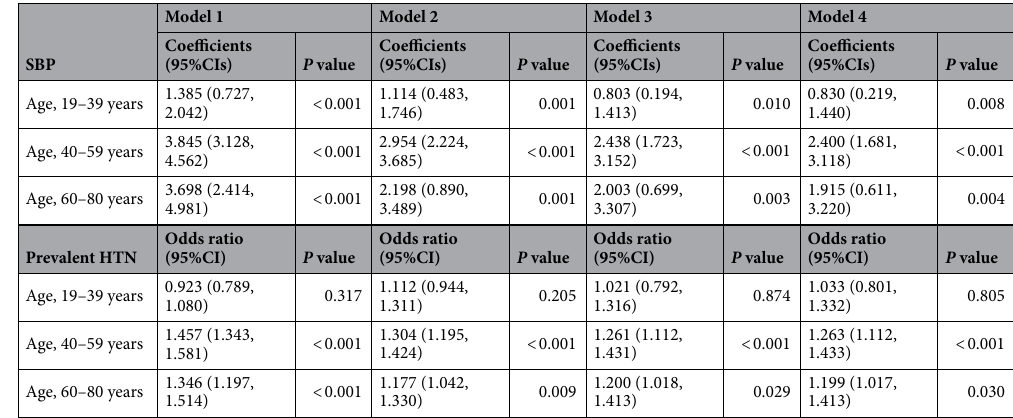
Table 2. Impact of low educational status on SBP and prevalent HTN in the subgroups stratified by age. Model 1, unadjusted. Model 2, adjusted for age and sex. Model 3, model 2 + adjusted for co-morbidities (high body mass index, high waist circumference, diabetes, dyslipidemia, coronary artery disease, stroke, and history of smoking). Model 4, model 3 + adjusted for eGFR and proteinuria). CI, confidence interval; HTN, hypertension; SBP, systolic blood